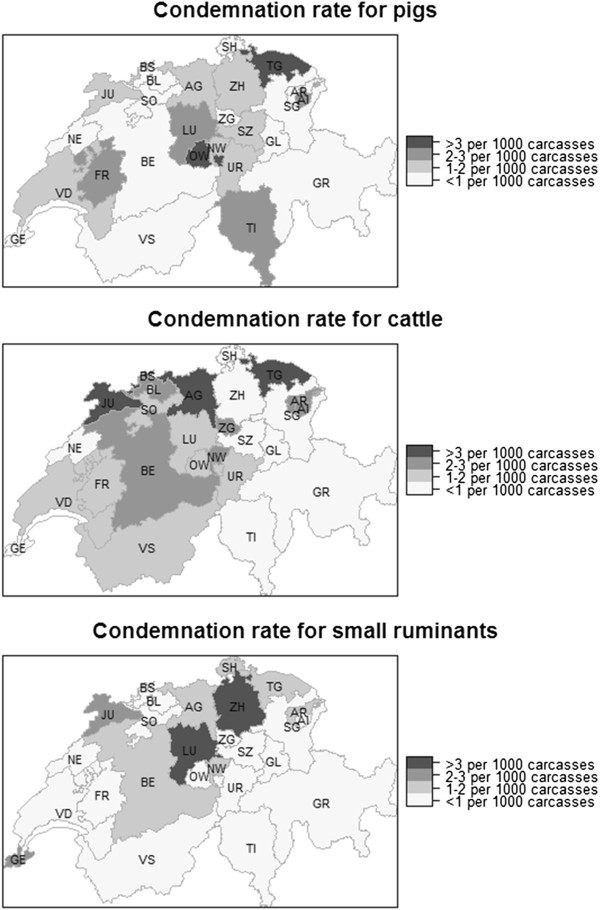
Cantonal differences in carcass condemnation rate. Map of Switzerland showing carcass condemnation rate (per 1,000 carcass inspected during normal slaughter) between 2007 and 2012 based on the location of slaughterhouses, and aggregated per canton for pigs, cattle and small ruminants. Swiss cantons: AG Aargau; AI Appenzell I. Rh.; AR Appenzell A. Rh.; BE Bern; BL Basel-Landschaft; BS Basel-Stadt; FR Fribourg; GE Geneva; GL Glarus; GR Graubünden; JU Jura; LU Lucerne; NE Neuchâtel; NW Nidwalden; OW Obwalden; SG St. Gallen; SH Schaffhausen; SO Solothurn; SZ Schwyz; TG Thurgau; TI Ticino; UR Uri; VD Vaud; VS Valais; ZG Zug and ZH Zürich.